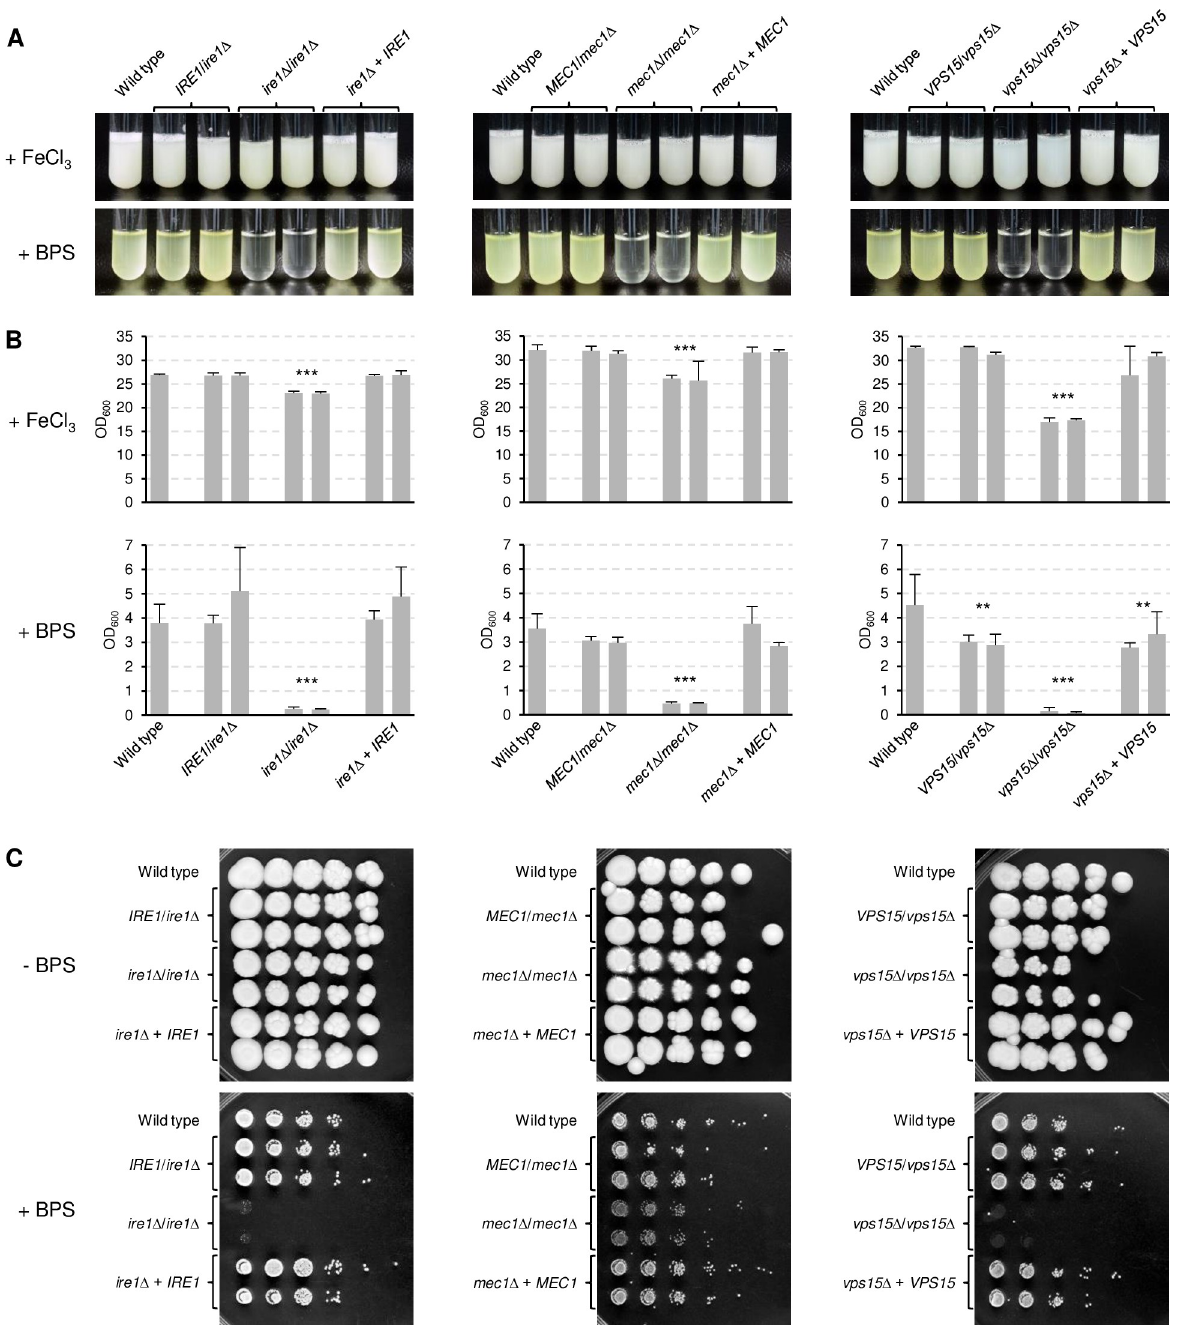
Fig 3. The protein kinases Ire1, Mec1, and Vps15 are required for growth under iron-limiting conditions. (A) The wild-type strain SC5314, heterozygous and homozygous ire1 Δ , mec1 Δ , and vps15 Δ mutants, and complemented strains were grown in minimal medium with (+ FeCl 3 ) or without iron (+ BPS). Cultures were photographed after 4 days of growth at 30˚C. Both independently generated series of strains are shown. (B) The optical densities of the cultures were determined; shown are the means and standard deviations of three independent cultures of each strain. Data for both independently generated series of strains were combined for statistical analysis. Significant differences from the wild type are indicated by stars ( ��� , p < 0.001). (C) YPD overnight cultures of the strains were serially 10-fold diluted, spotted on YPD agar plates without or with BPS, and grown for 4 days at